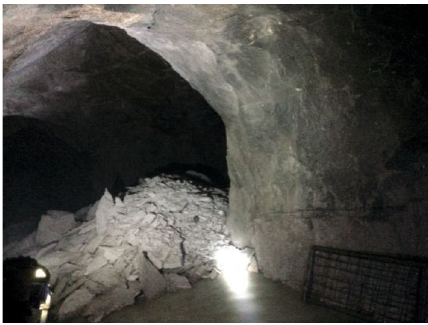
Figure 2: Rockburst at the intersection between lower drainage corridor and tailrace branch tunnel no. 1.